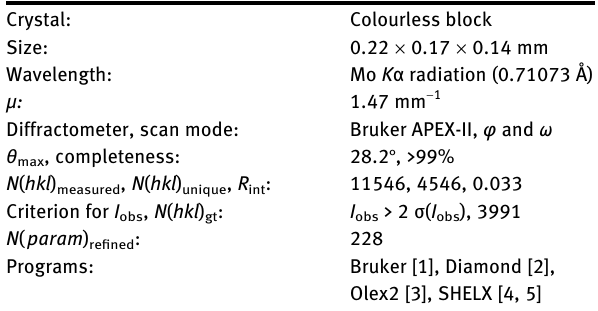
Figure 1: The asymmetric unit of the title compound, showing the atomic numbering scheme and 50% thermal displacement ellipsoids. Table  : Data collection and